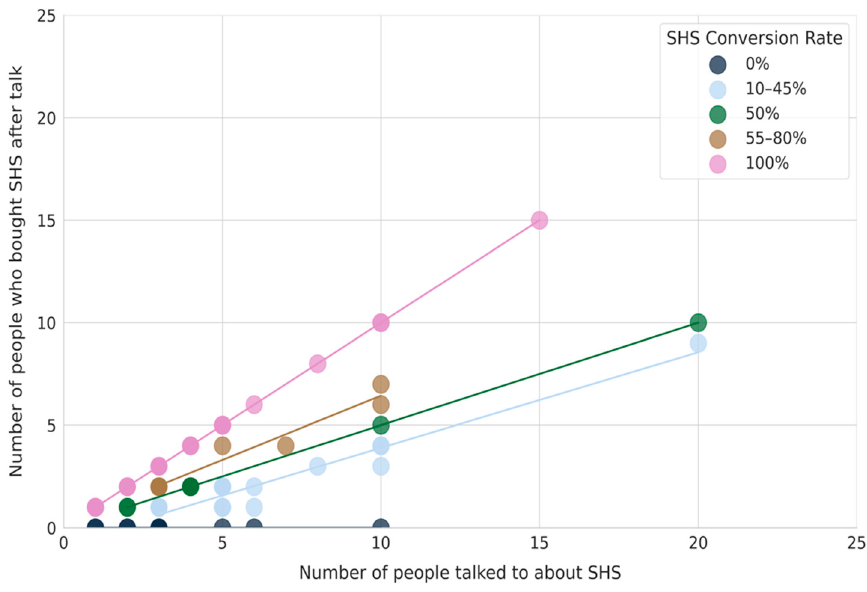
Figure 7. Number of people talked to about SHS versus number buying a SHS afterwards.